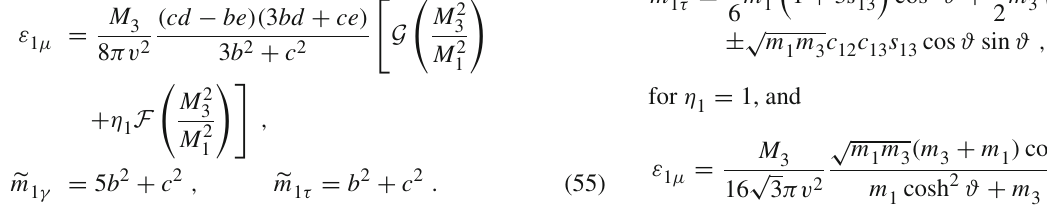
= 1 and − 1 in the case of 2